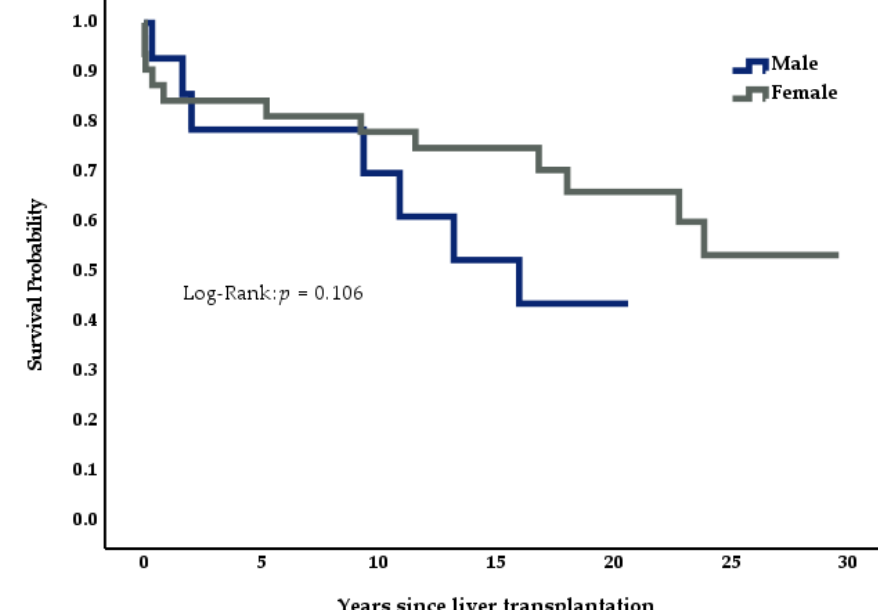
Figure 5. Impact of gender on survival, n = 46.